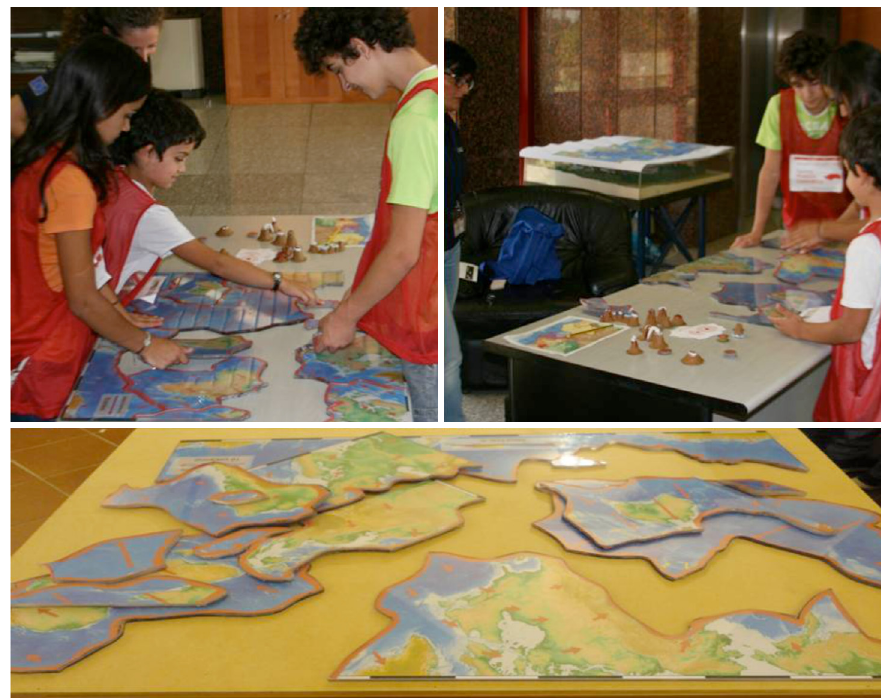
Figure 2. Laboratory activities of “Scientists as a game”: The plate-tectonic puzzle . Small play-dough vol- canoes and earthquake epicenters have to be placed according to the plate